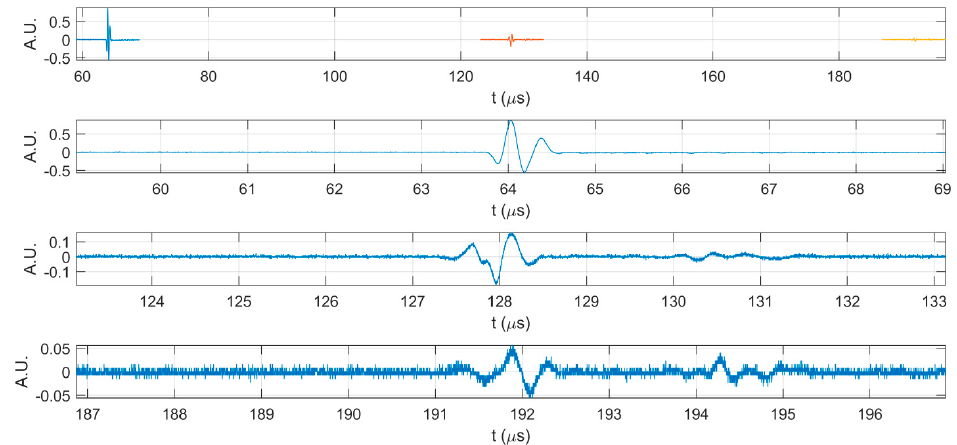
Figure 3. The first three echoes acquired for CD-HAp_1 sample: together ( top ); and separated ( below ).